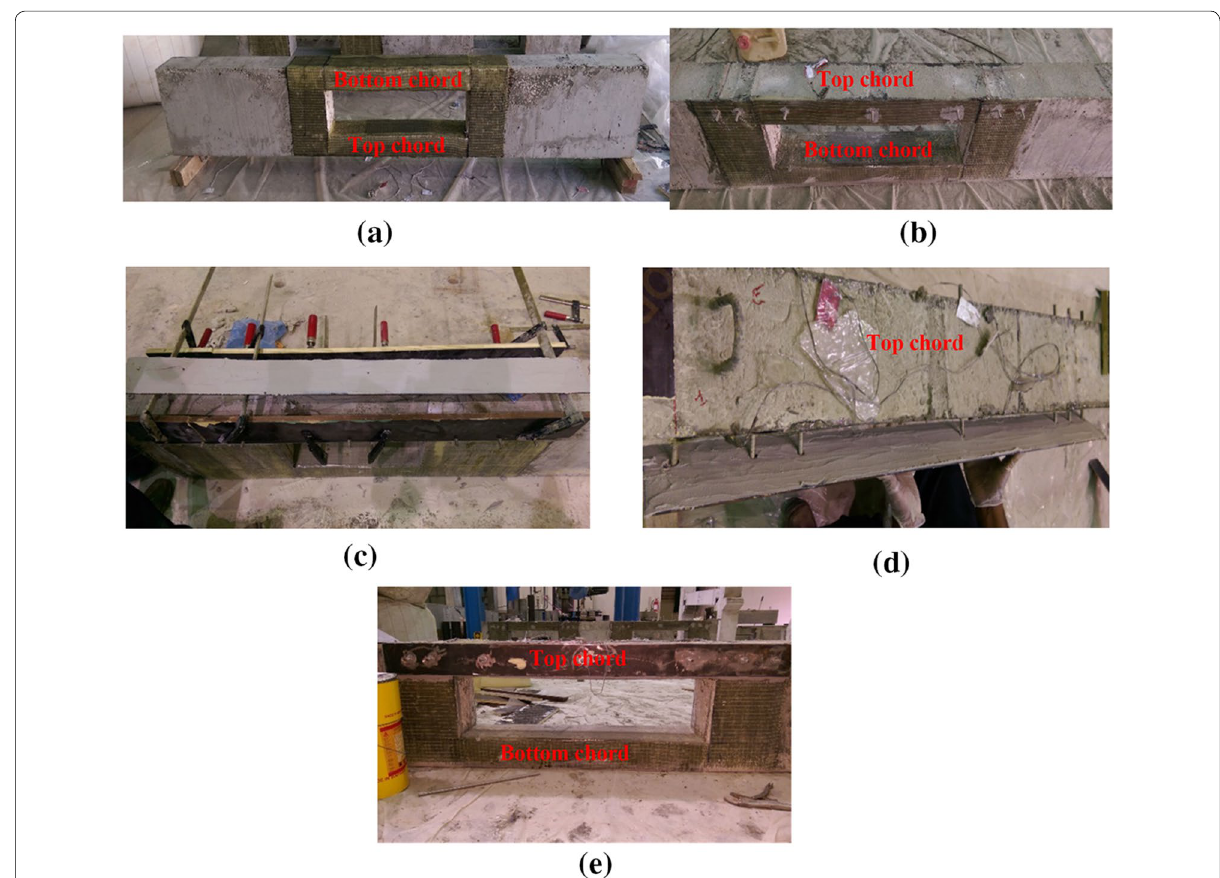
Fig. 7 Steps involved in strengthening of beam BS2‑O2‑CPL using scheme‑2: a GFRP‑strengthened beam, b holes drilled and threaded rods passed, c sika‑41 epoxy applied to steel plates, d steel plates passed through the rods, and e strengthened beam ready for